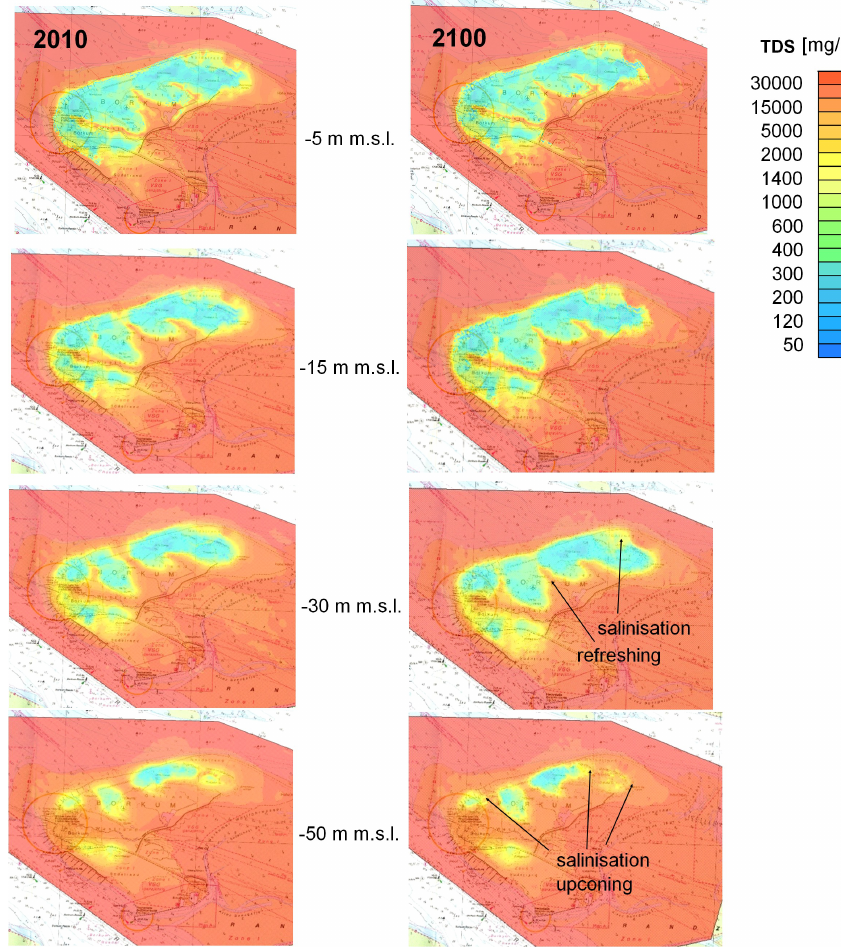
Fig. 18. Computed freshwater lens in 2010 (left panel) and 2100 (right